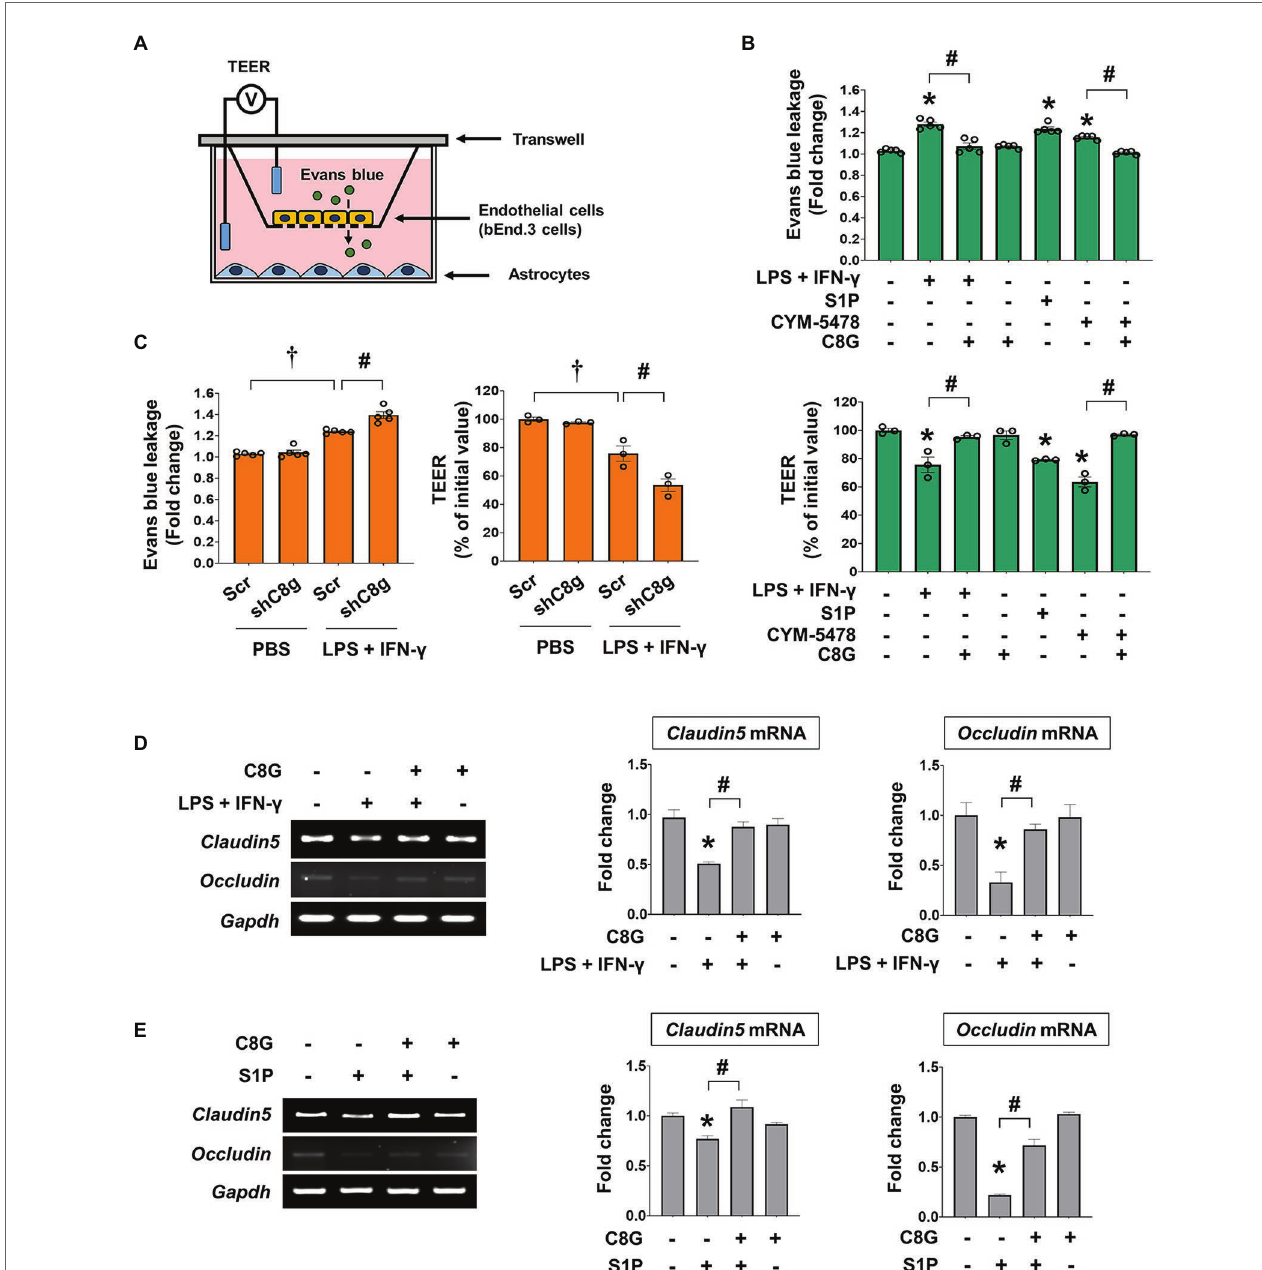
FIGURE 4 | Complement component 8 gamma modulates the permeability of ECs after inflammatory stimulation. (A) Schematic representation of the in vitro model of the BBB. (B) C8G attenuated the permeability of ECs after inflammatory stimulation. bEnd.3 cells were grown on the inside of transwell inserts (apical side), and mouse primary astrocytes were cultured on the bottom side (basolateral side). Cells were pretreated with recombinant C8G (1 μ g/ml) for 2 h and then exposed to LPS (1 μ g/ml) + IFN- γ (50 U/ml), S1P (1 μ M), or CYM5478 (1 μ M) for 24 h. Left panel: Evans blue leakage was measured as described in the Materials and Methods. Data are presented as fold change compared with the control. Right panel: the transendothelial electrical resistance (TEER) across the membrane was assessed after pretreatment of the C8G protein and the administration of LPS and IFN- γ , S1P, or CYM5478. (C) Knockdown of C8G exacerbated the permeability of ECs after inflammatory stimulation. bEnd.3 cells were grown on the inside of transwell inserts (apical side), and mouse primary astrocytes infected by AAV-shRNA C8g were cultured on the bottom side (basolateral side). After the administration of the treatments described in (B) , Evans blue leakage (left panel) and TEER (right panel) were evaluated. (D) The recombinant C8G protein rescued the mRNA level of tight junction genes, which were downregulated by LPS + IFN- γ in bEnd.3 cells. After a 2 h C8G pretreatment (1 μ g/ml), bEnd.3 cells were exposed to LPS (1 μ g/ml) and IFN- γ (50 U/ml) for 12 h ( n = 3 each). (E) The recombinant C8G protein rescued the mRNA level of tight junction genes, which were downregulated by S1P in bEnd.3 cells. After a 2 h C8G pretreatment (1 μ g/ml), bEnd.3 cells were exposed to S1P (1 μ M) for 12 h ( n = 3 each). Data are the mean ± SEM. * p < 0.05 vs. the control, # p < 0.05, and † p < 0.05 vs. shScr + PBS; Tukey’s multiple comparisons test after one-way